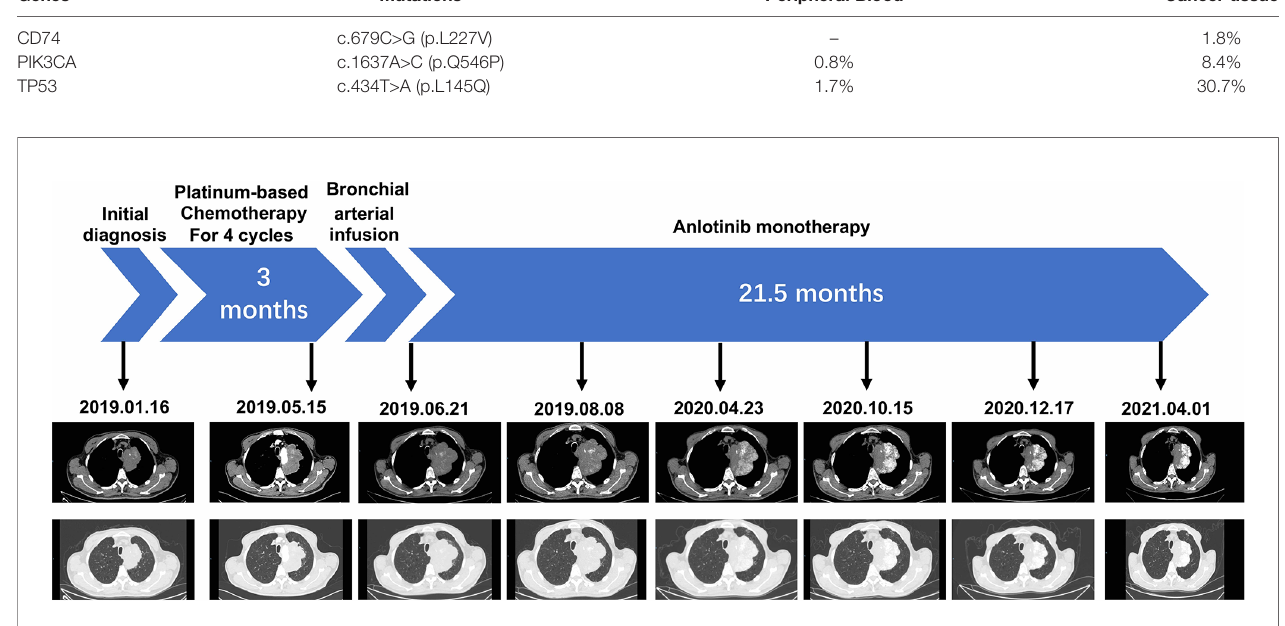
FIGURE 2 | Graphic summary of the case.